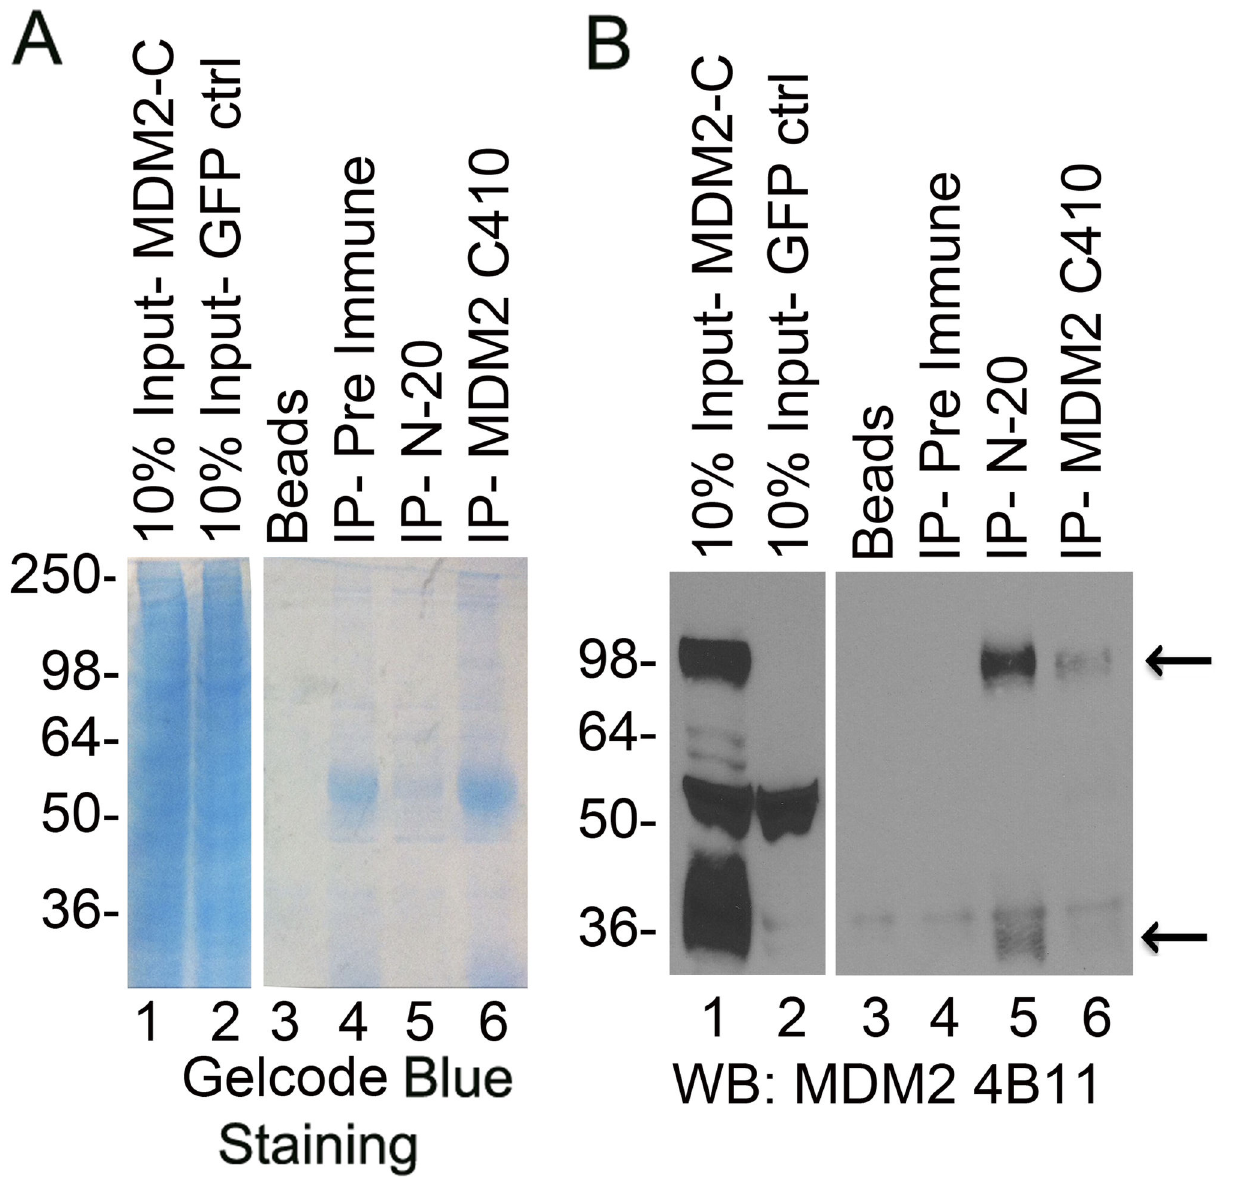
Figure 3. Human MDM2-C migrates at 98 kDa. Immunoprecipitation using MDM2 C410 and pre-immune polyclonal serum antibodies with HeLa in vitro translated MDM2-C extracts using pre immune sera, MDM2 C410 and N-20 polyclonal antibodies. Samples were electrophoresed onto a 10% SDS-PAGE gel in duplicate. A . One half was stained with coomassie blue for protein detection. B . Samples from half of gel were transferred to nitrocellulose membrane and MDM2 was detected with 4B11 monoclonal antibody. HRP-conjugated anti-mouse was used as secondary antibody. Arrows depict MDM2-C protein.